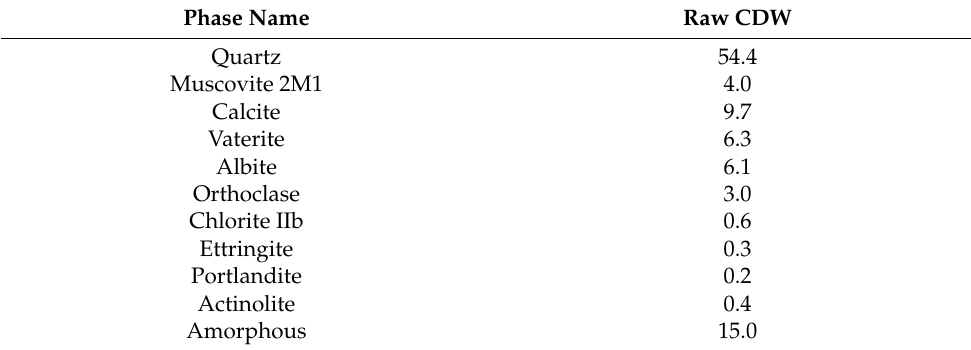
Table 1. Mineralogical composition of CDW (wt.